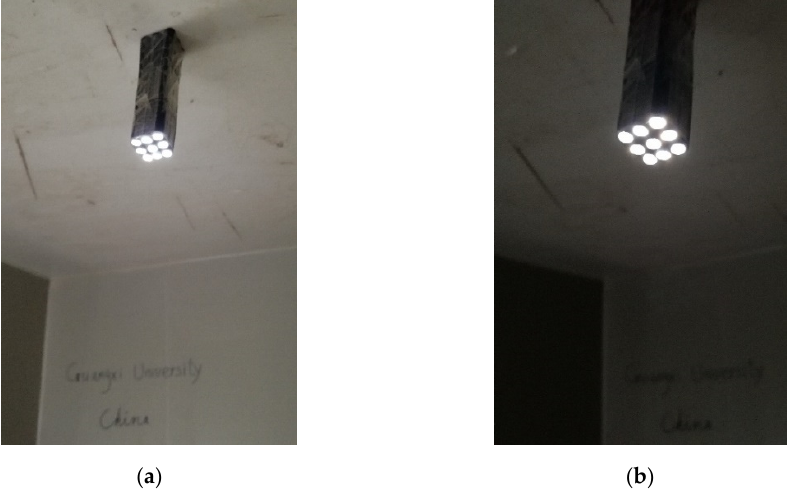
Figure 13. Photo of the end of the fiber bundle ( a ) with auxiliary light; ( b ) without auxiliary light. The latitude of the experimental site is 23 ◦ . When testing, the center line of the light guide system directs to the solar noon position of the sun. Because the sun moves 1 ◦ every 4 min, the range of effective output illuminance received by the fixed light guide system is 64 ◦ , which is more than 4 h of sunshine, that is, 2 h before noon and 2 h after noon. The measured data are shown in Figures 14 and 15. The red curve is the irradiance of incident sunlight and the purple curve is the output